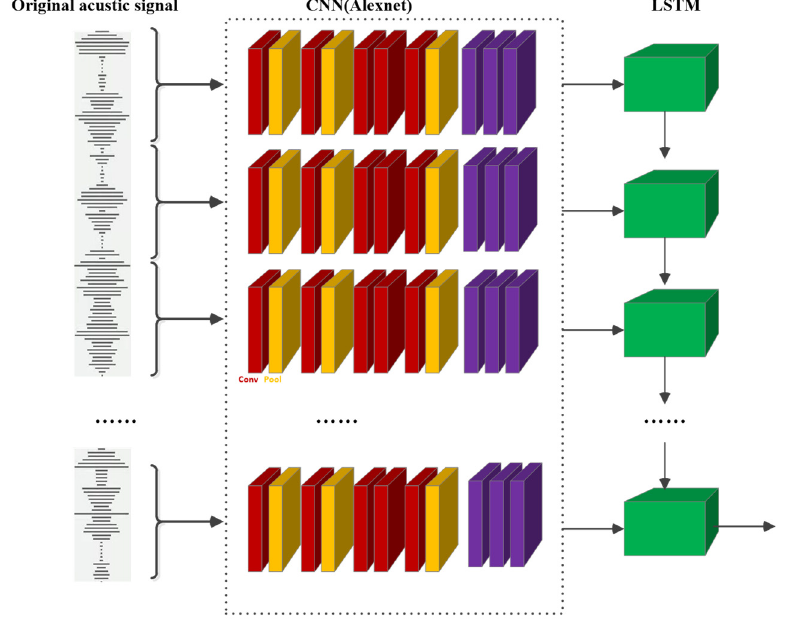
Figure 1. The module of violent auditory feature extraction.